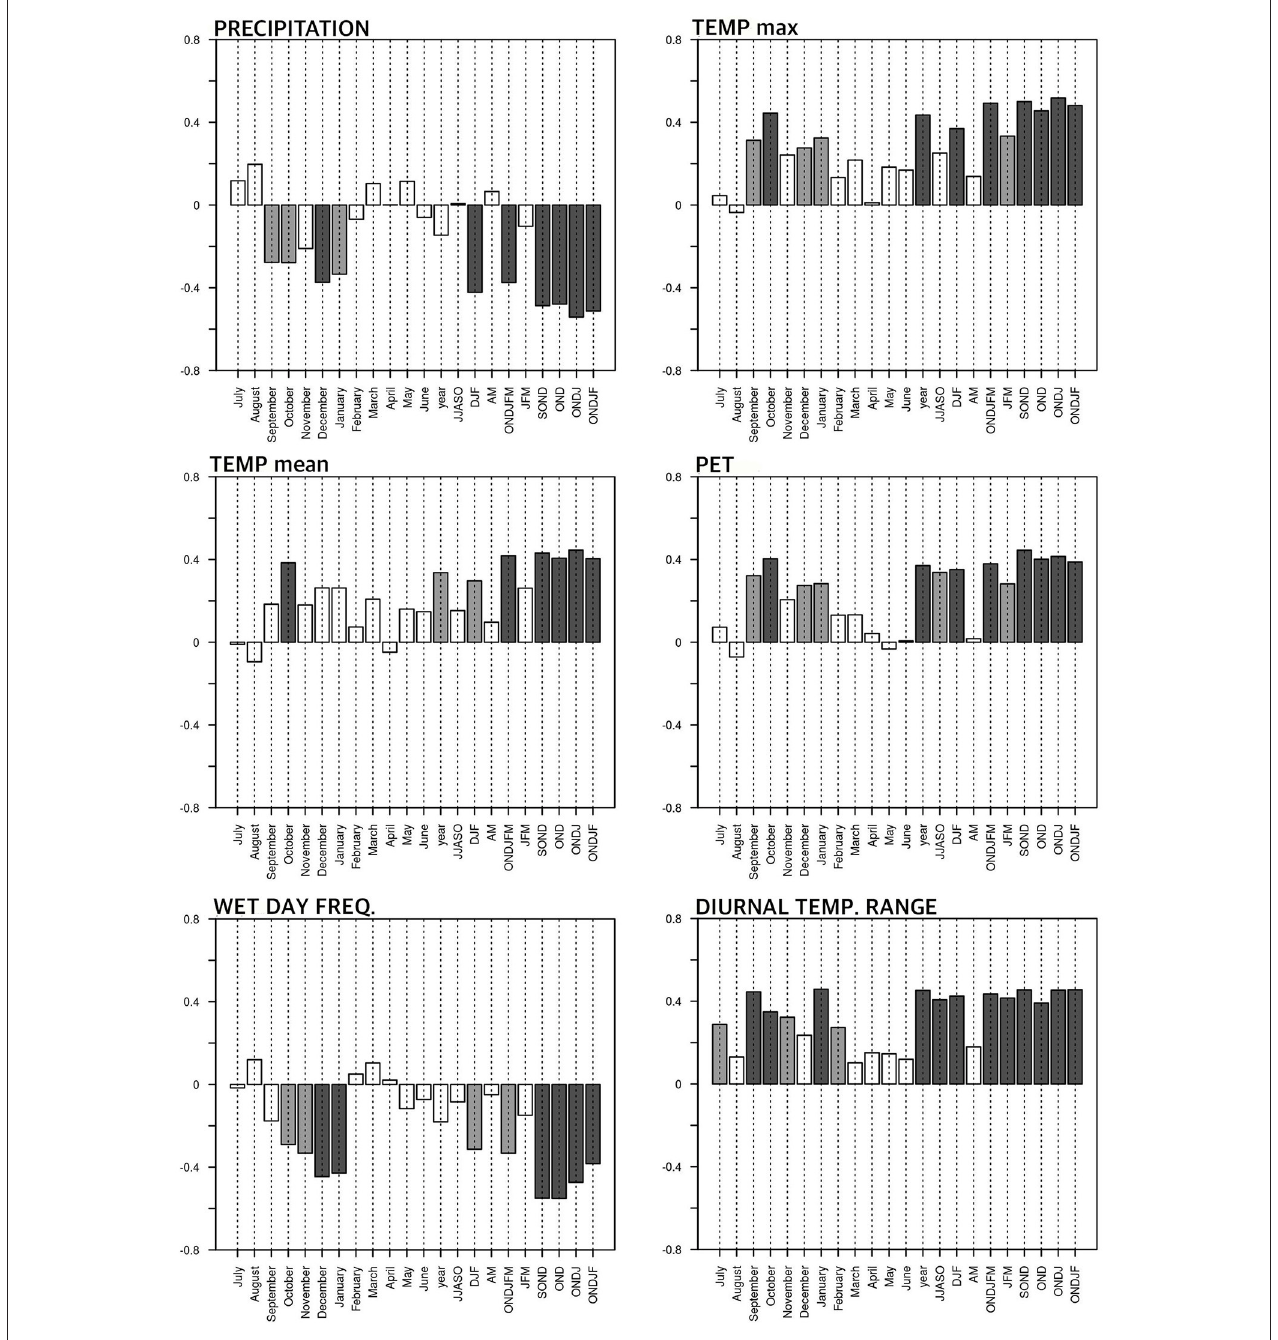
FIGURE 6 | Climate-proxy-relationship between our δ 18 O TRC time series and the six most sensitive climate parameters of the calculated regional mean CRU 4.02 data. Light gray bars indicate correlations reaching the p < 0.05 level of significance, dark gray bars correlations exceeding the p < 0.01 level of significance.